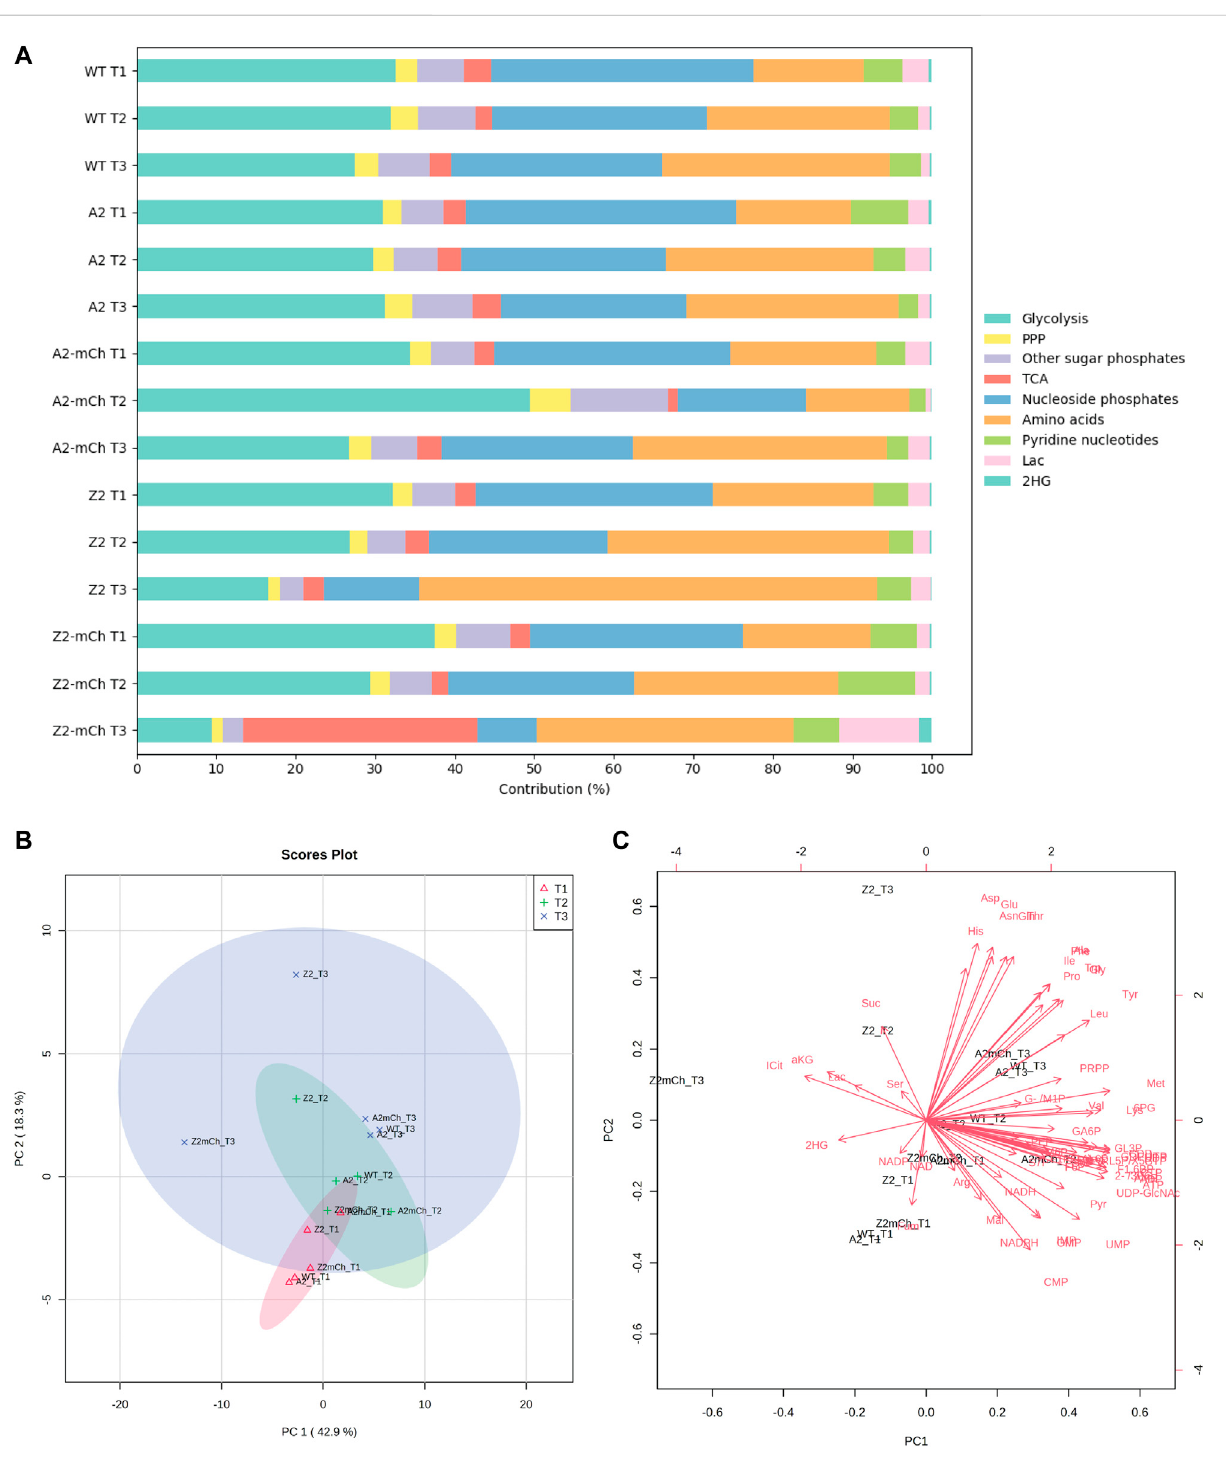
FIGURE 4 General overview of the metabolic state of each strain during thetime series (A) Stack bar diagram showing a time series of the relative contribution (%) of metabolites to the total quanti fi ed metabolite levels, grouped by pathway or metabolite class (B) 2D scores plot from principal component analysis (PCA)oftheaveragesofeachstrain.PriortothePCA,thedatasetwasautoscaled(mean-centeredanddividedbythesquarerootofthestandarddeviation of each variable) in MetaboAnalyst 5.0 (Pang et al., 2021). The colored shaded areas indicate the 95% con fi dence interval of PC1 and PC2 for each group (C) Biplot of PC1 versus PC2. In total, 61.2% of the variation in the data can be explained by PC1 and